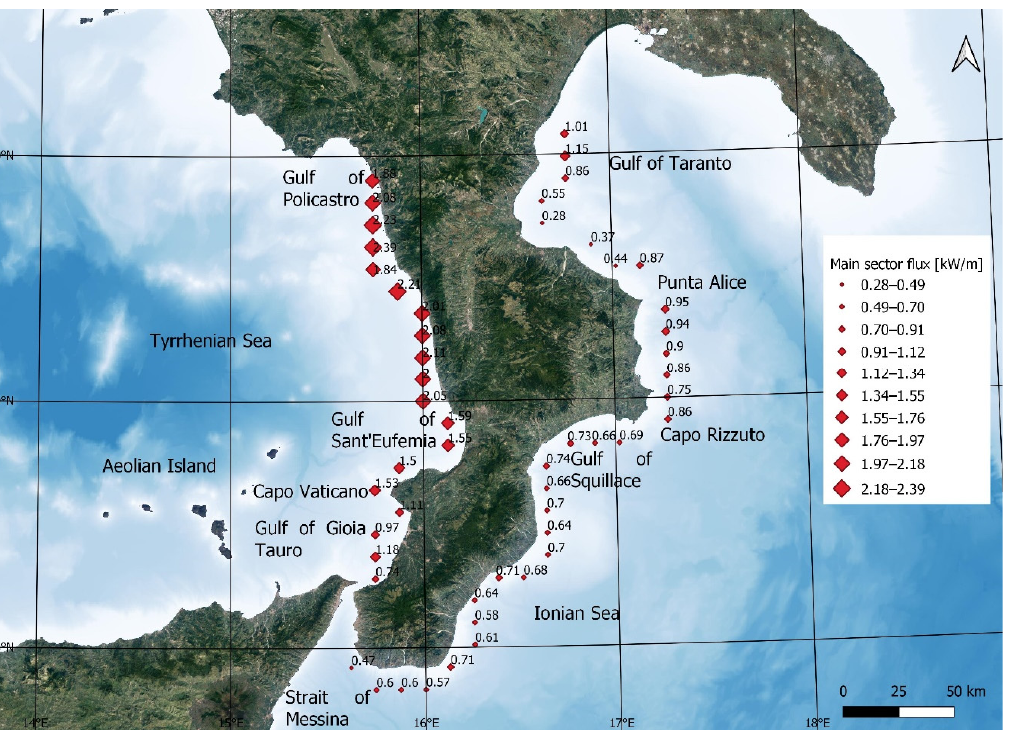
Figure 8. Average annual energy flux of main sectors Φ MS values. The range between the minimum and the maximum values has been divided into 10 intervals of the same width.